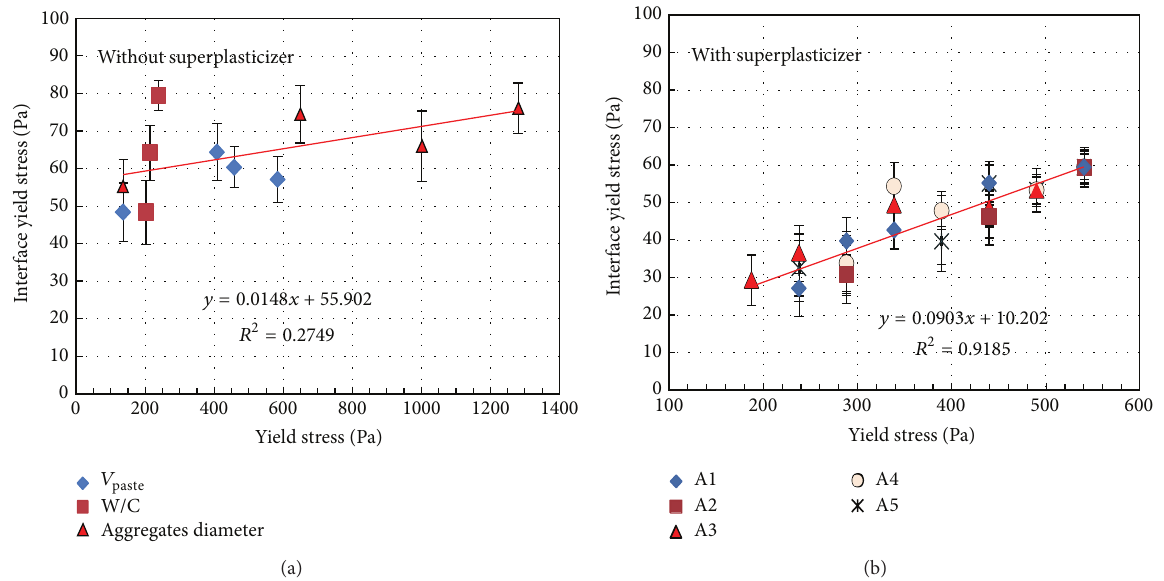
Figure 13: Evolution of the interface yield stress 𝜏 0𝑡 according to the concrete yield stress 𝜏 0 calculated by (14): (a) concretes series without superplasticizer and (b) concretes series with